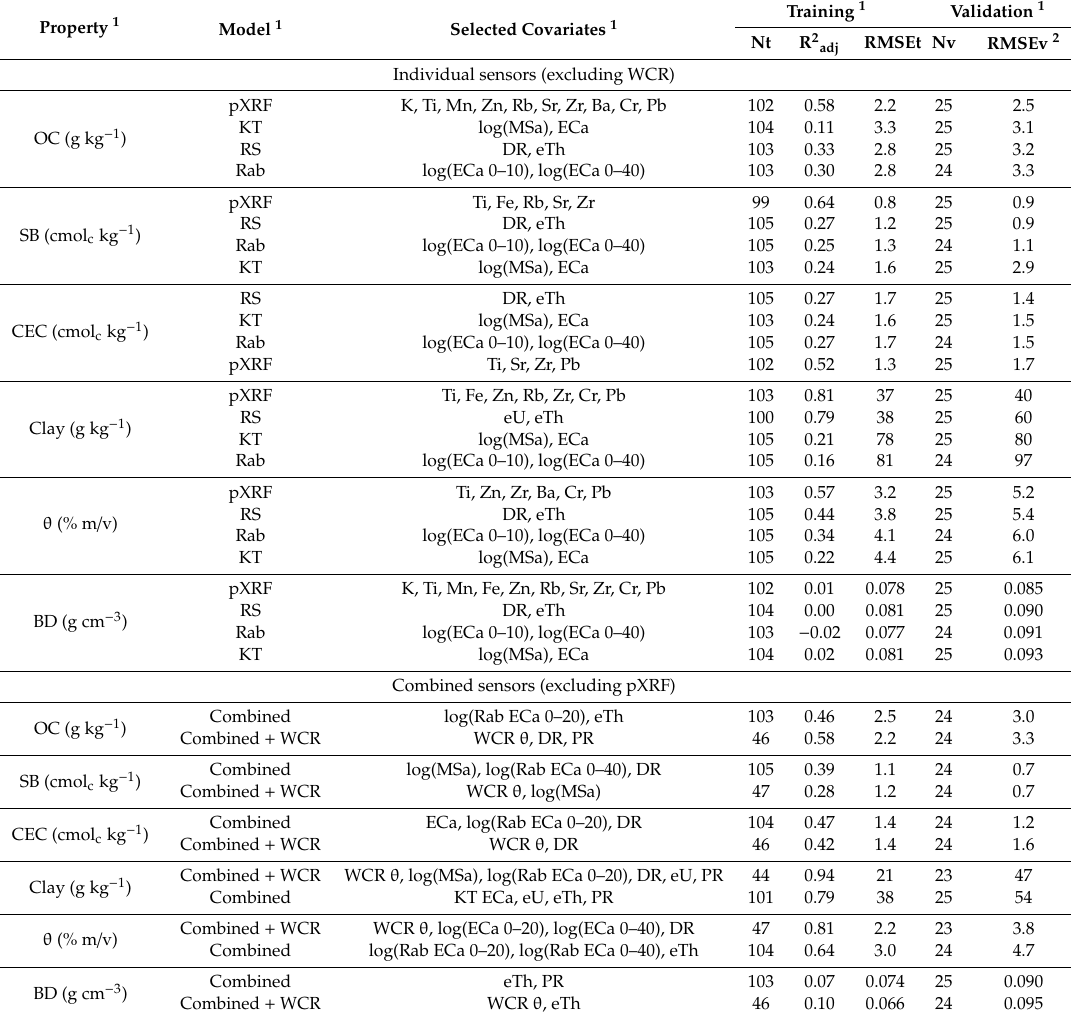
Table 3. Model training and validation results for the laboratory soil properties predicted as a function of data from individual and combined proximal soil